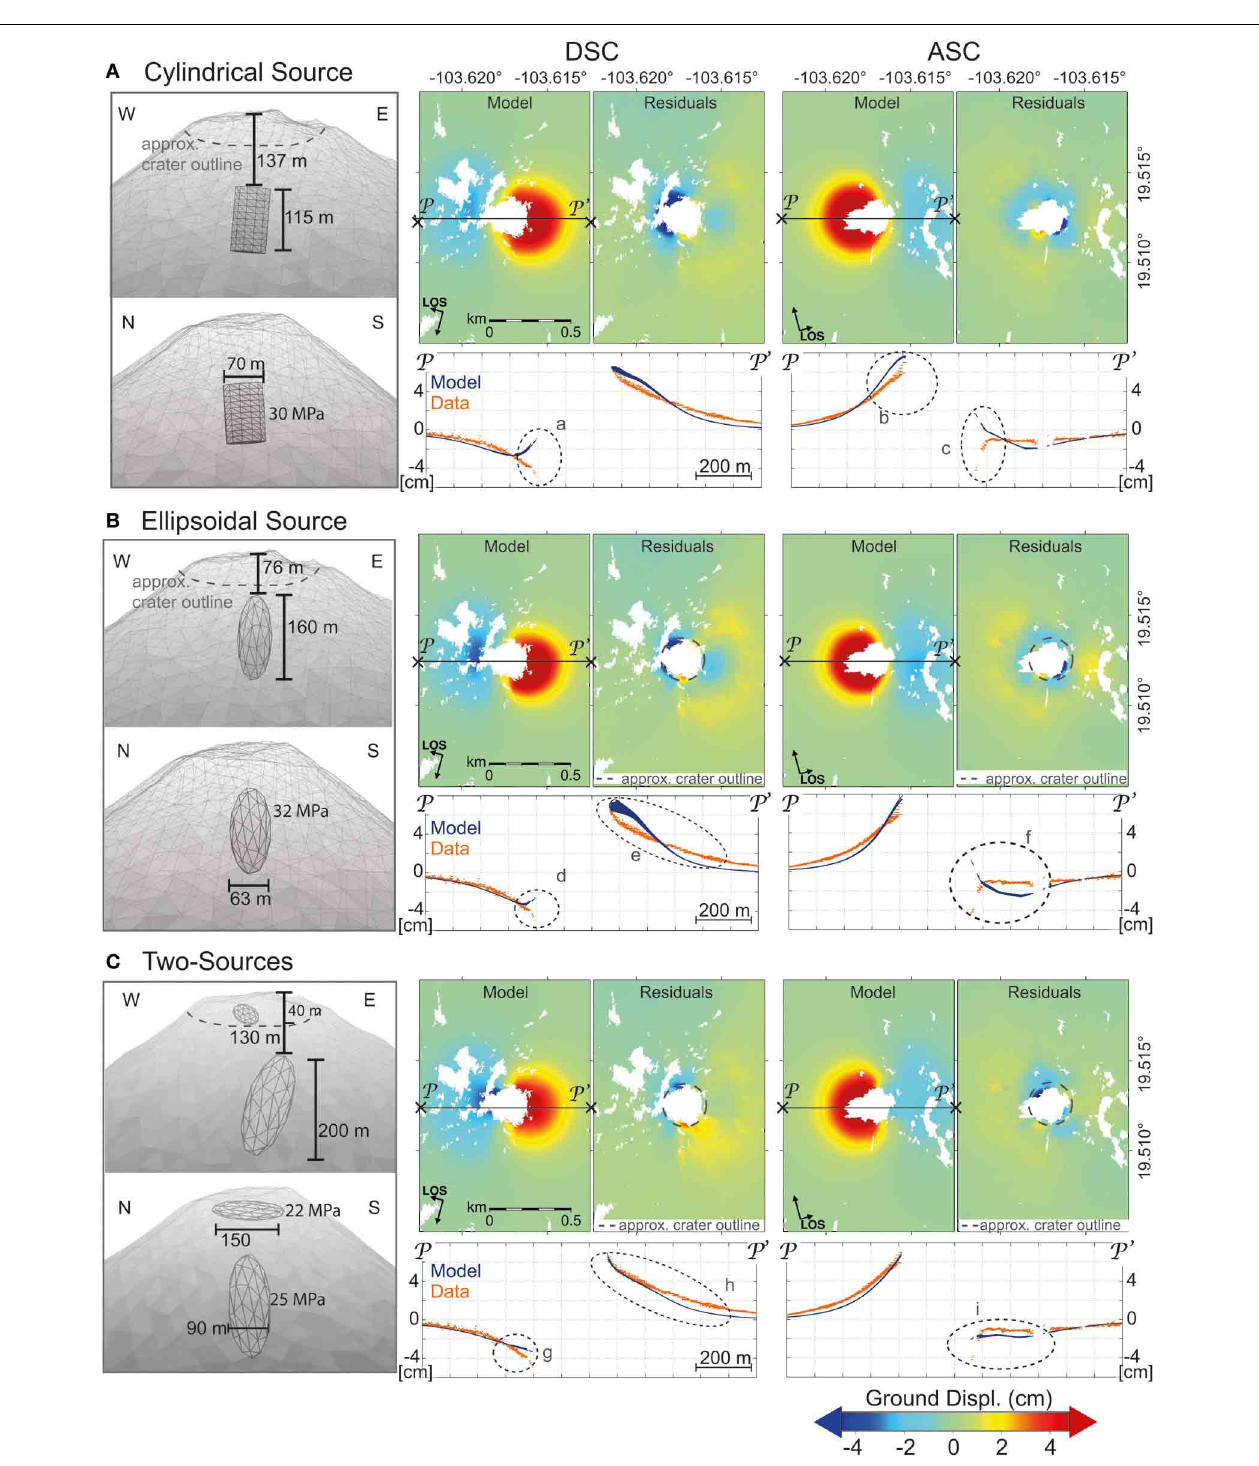
FIGURE 5 | Boundary element modeling results. Three different model setups are shown: a cylindrical source (A) , an ellipsoidal source (B) and a combination of two ellipsoids (C) . For each, we present the best-fitting source geometry and its parameters. In addition, we provide maps showing the modeled displacements and residuals in both look